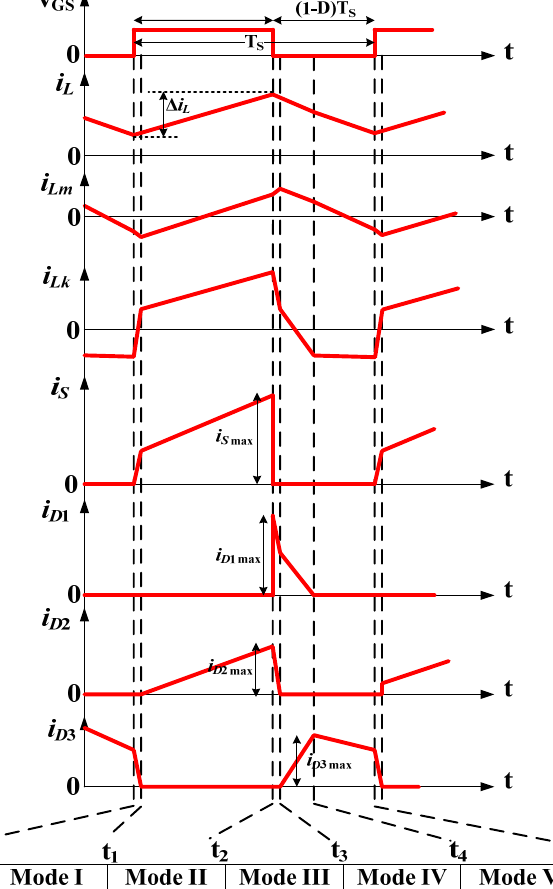
Figure 3. The typical waveforms of the presented converter in steady-state operation.